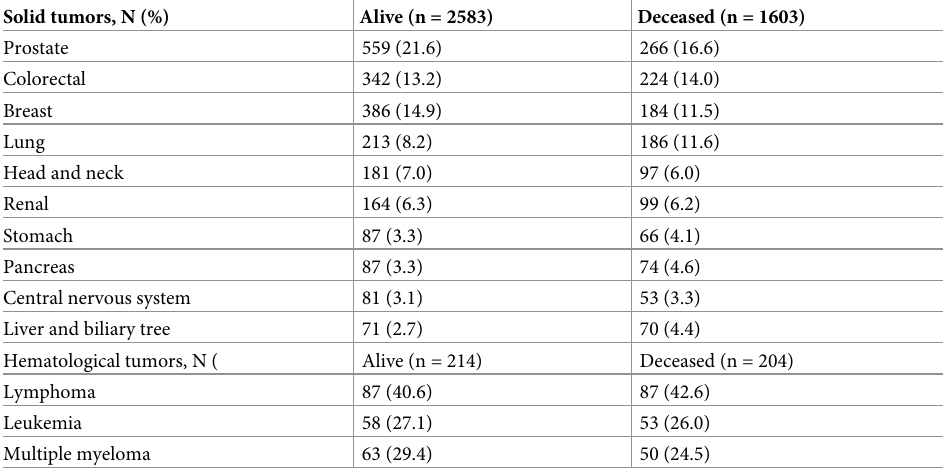
Table 2. Type of tumors.